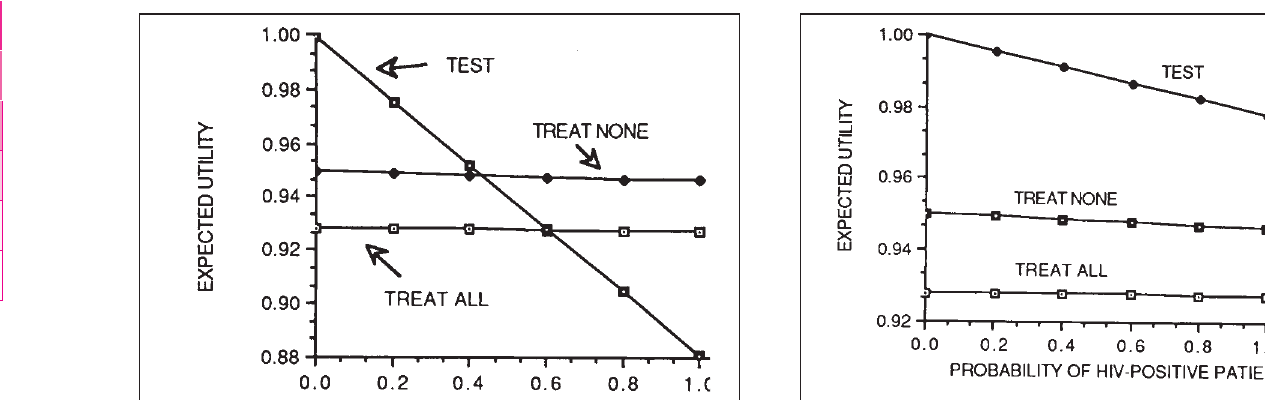
Figure 2) Varying the prevalence of HIV infection in the patient popu- lation (one-way sensitivity analysis). The treat none option becomes preferred when the prevalence of HIV exceeds 42%.